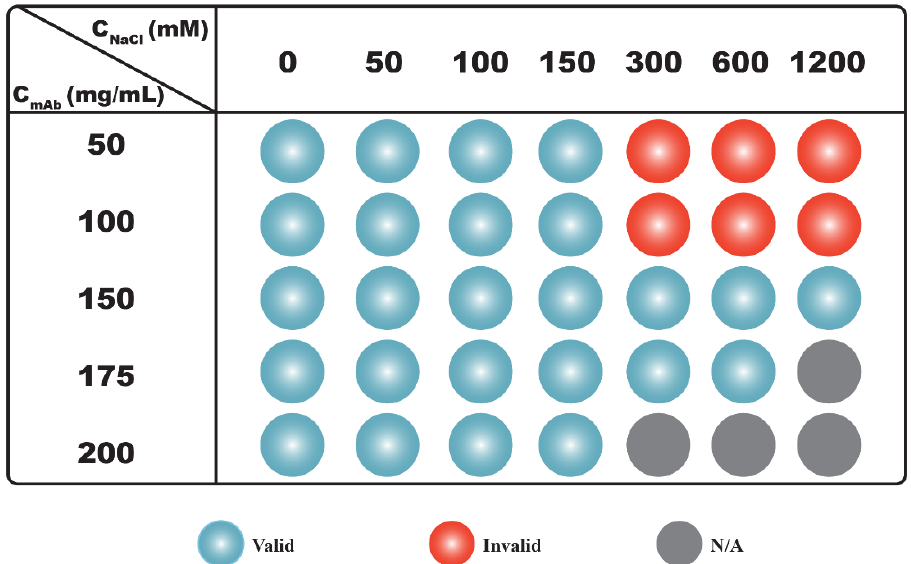
Figure 3. Correlations between k D and S (0) eff values. Conditions under which k D is greater than − 8 mL/g and S (0) eff value is less than 1 are represented with blue spheres. Under these conditions, both parameters suggest the net PPI are repulsive. Conditions under which k D is greater than − 8 mL/g, but S (0) eff is greater than 1 are represented with red spheres. Under these conditions, k D values sug- gest net PPI are repulsive, while S (0) eff values suggest the net PPI are dominated by attractions. Ex- perimental conditions under which mAb samples are not prepared/measured are shown in grey.